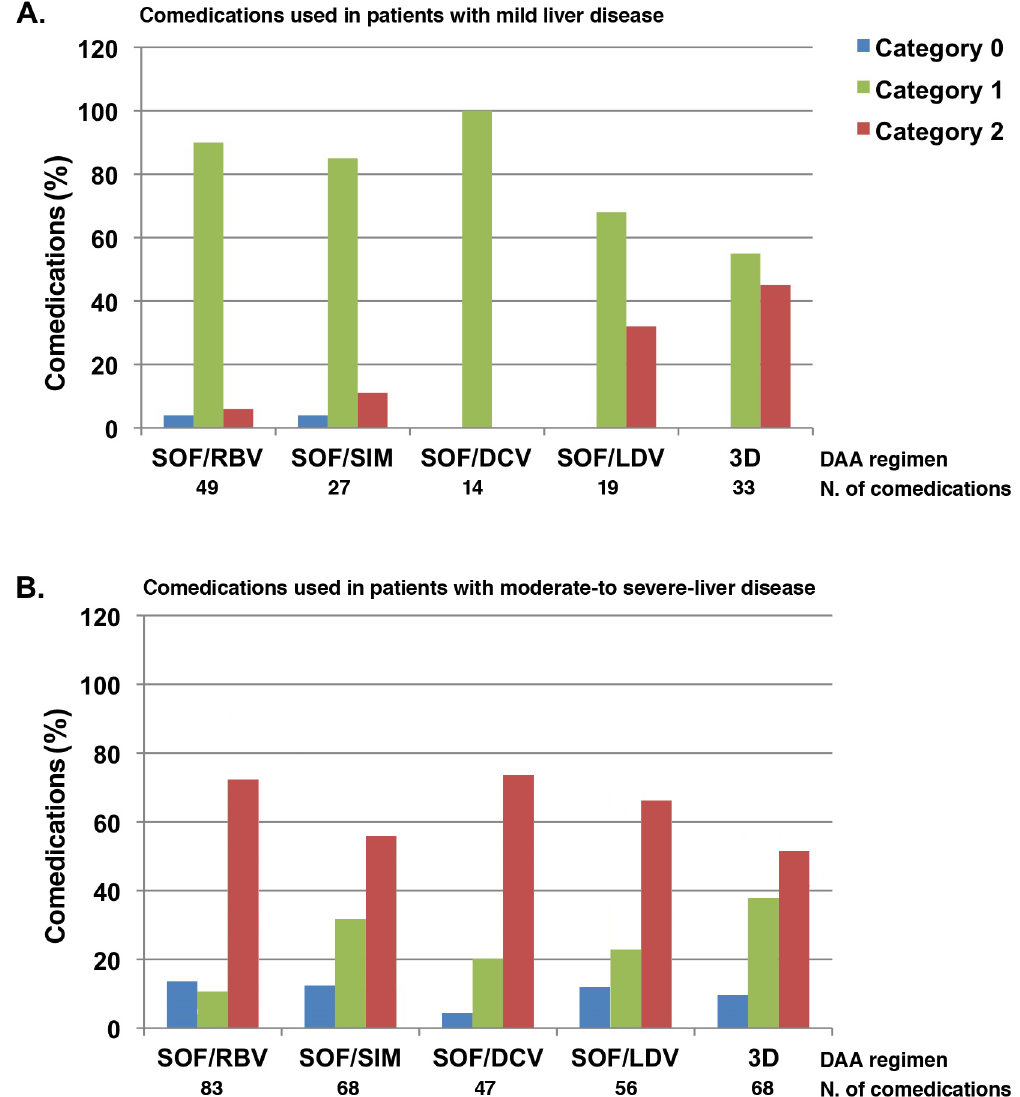
Fig 2. Category of potential DDIs, by DAA regimen and severity of liver disease, among HCV-infected patients. Comedication used in patients with mild liver disease (A) or in (B) patients with moderate-to severe-liver disease (B). DAA regiments and number of comedications used are shown. SOF/RBV: sofosbuvir plus ribavirin, SOF/SIM: sofosbuvir plus simeprevir, SOF/DCV: sofosbuvir plus daclatasvir, SOF/LDV: sofosbuvir plus ledipasvir, 3D: paritaprevir/ritonavir, ombitasvir, dasabuvir. Category 0: Classification not possible due to lack of information; Category 1: No clinical interaction possible; Category 2: May require dose adjustment/closer